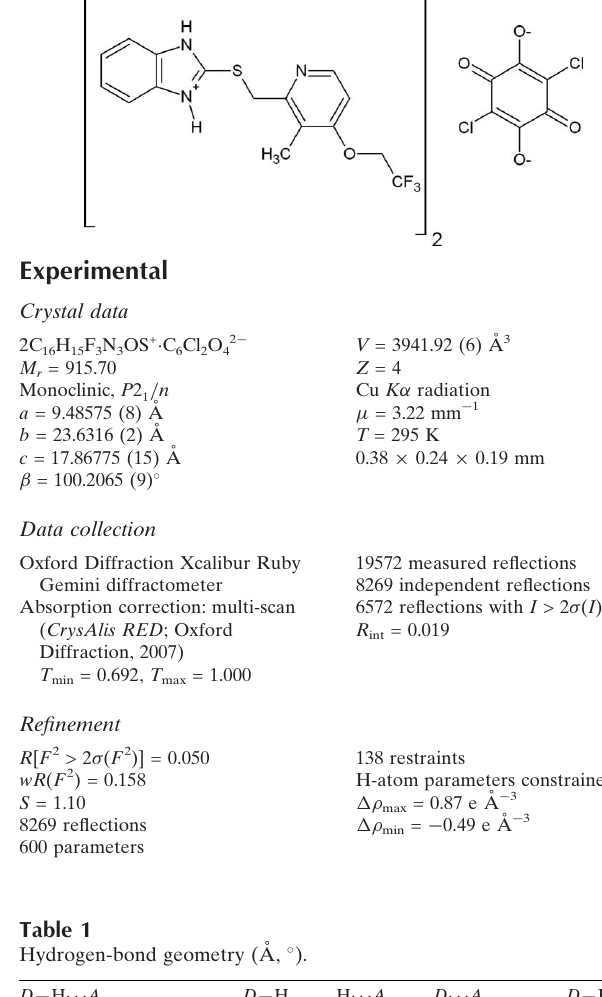
pyridine and benzimidazole rings are 11.1 (6) and 13.1 (5) (cid:4) ,